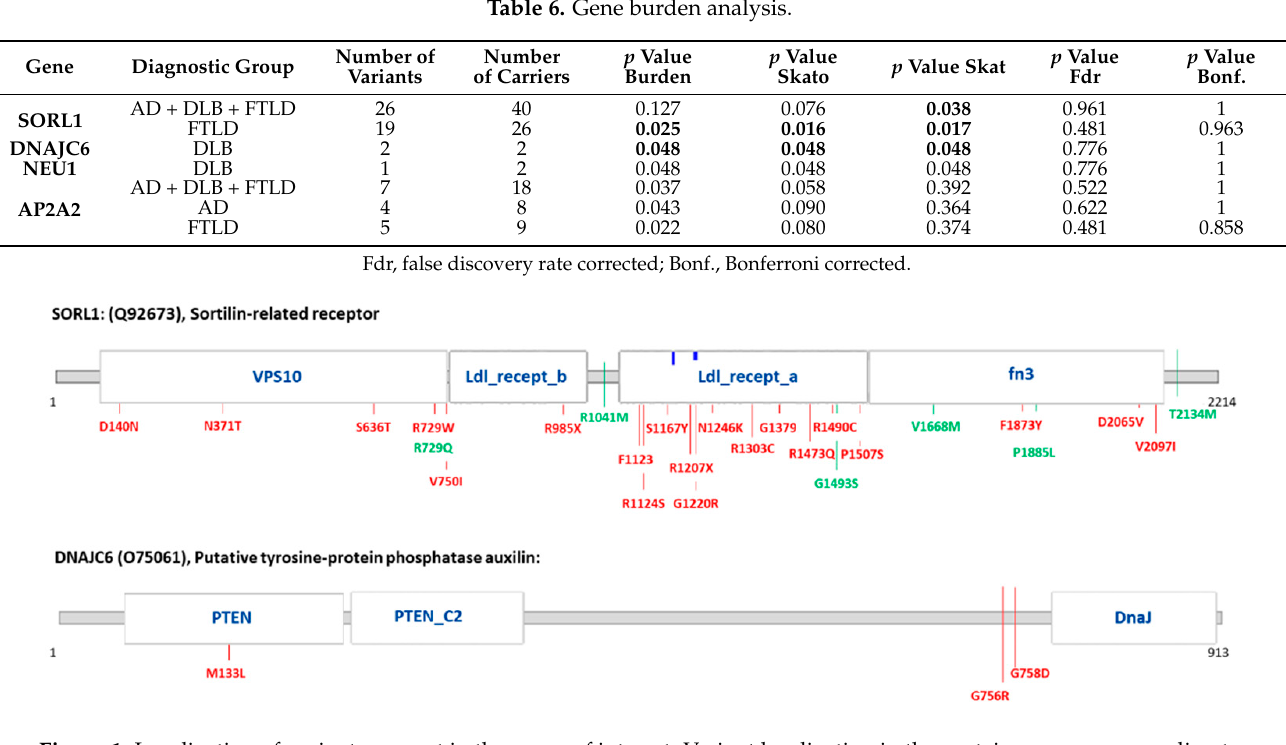
Figure 1. Localization of variants present in the genes of interest. Variant localization in the protein sequence, according to the Elaspic and Interpro webserver, and the relative functional domains involved. Variants present in the patient group are shown in red; Variants present in the control group are shown in green. VPS10: VPS10 domain; Ldl_recept_a: LDL receptor class a; Ldl_recept_b: LDL receptor class b; fn3: Fibronectin type 3 domain; PTEN: PTEN domain; PTEN_C2: C2 domain of PTEN tumor-suppressor protein; Dnaj: DnaJ domain.